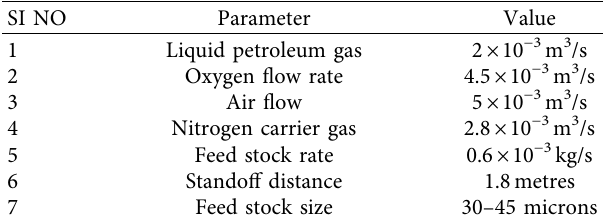
Figure 1: SEM and EDS of WC+10% Ni feed stock powder. Table 2: HVOF process conditions.